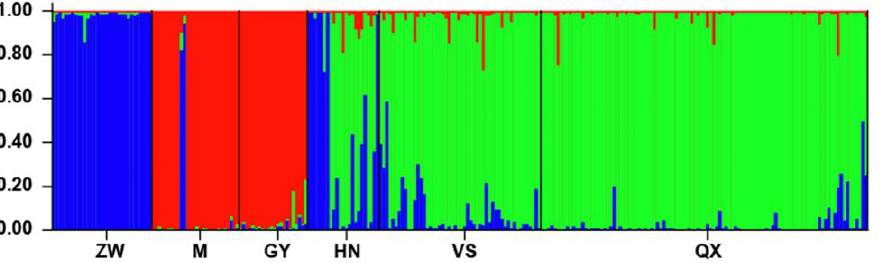
Figure 4. Admixture analysis of individual genotypes using Structure. Colors correspond to one of three clusters (see also Fig. 1), and each bar represents a single sample. See Table 1 for sample site abbreviations.